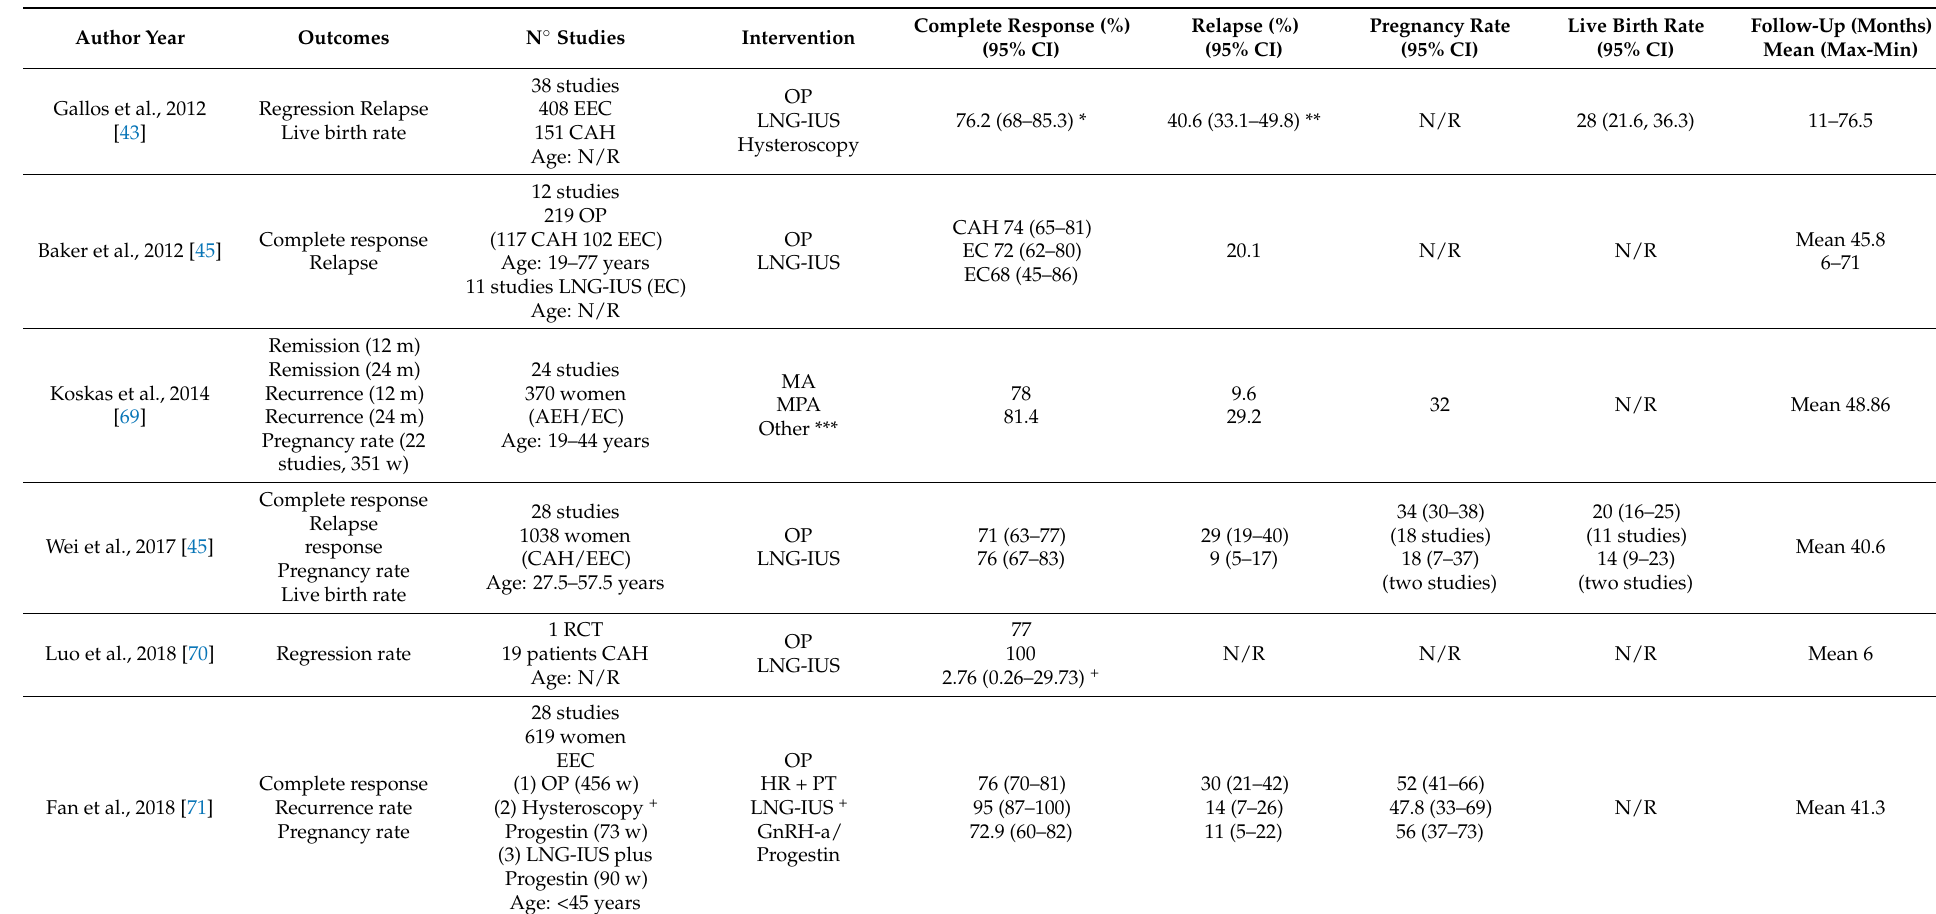
Table 3. Summary of Systematic reviews and Meta-analyses of Fertility-Sparing